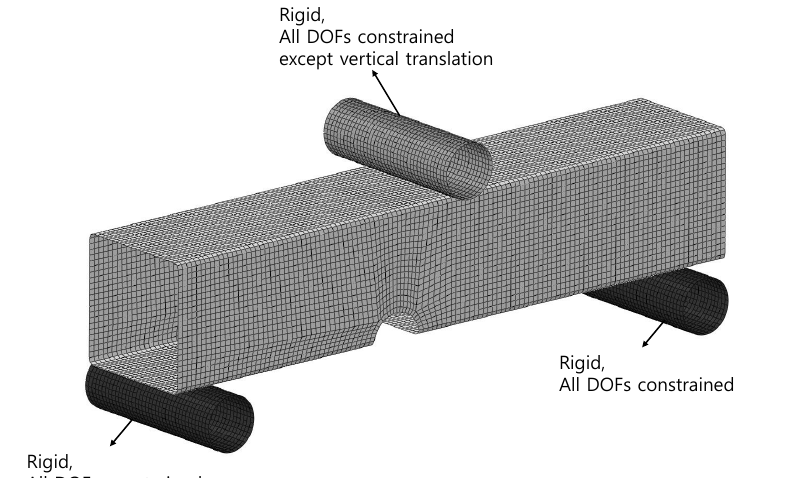
Figure 2. Finite element model of the test model, supports, and